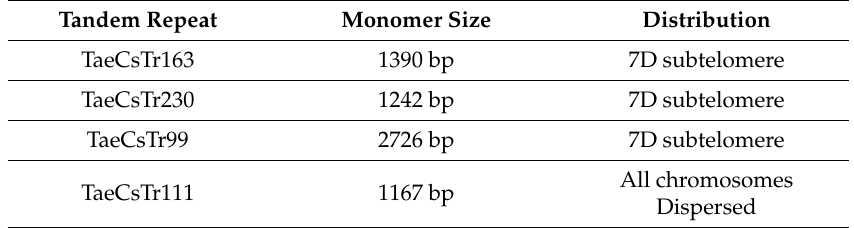
Table 1. Monomer sizes and distribution of identified tandem repeats. Tandem Repeat